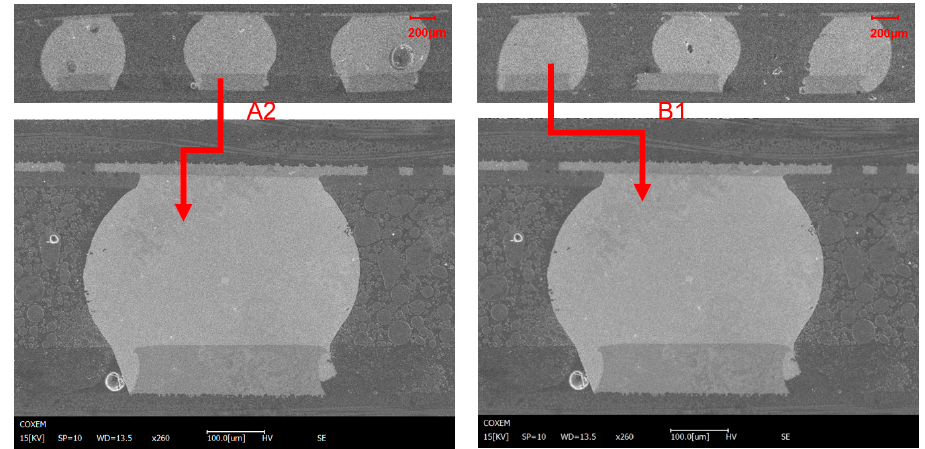
Figure 9. Diagonal cross-sectional SEM images of the solder joints after thermal shocks.